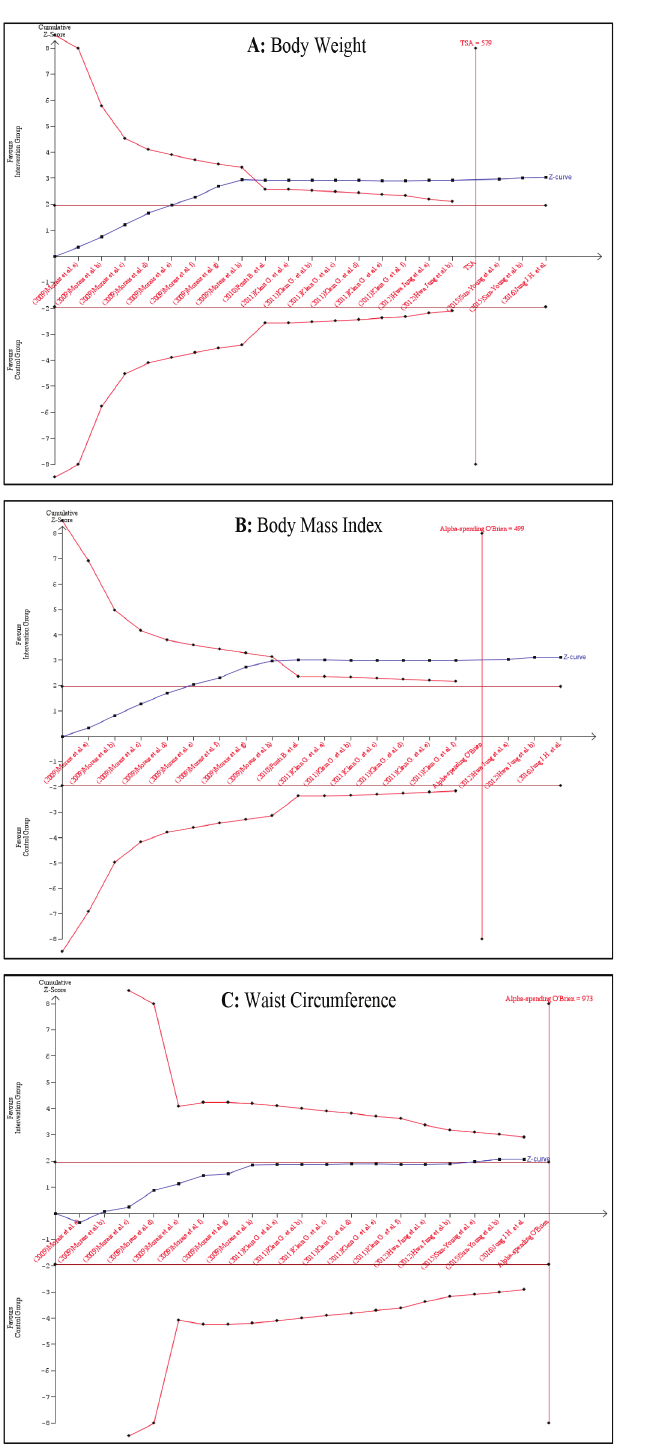
FIGURE 5 - Meta-regression plots of the association between calculated weighted mean differences (WMD) in body weight, body mass index (BMI) and waist circumference, and the study